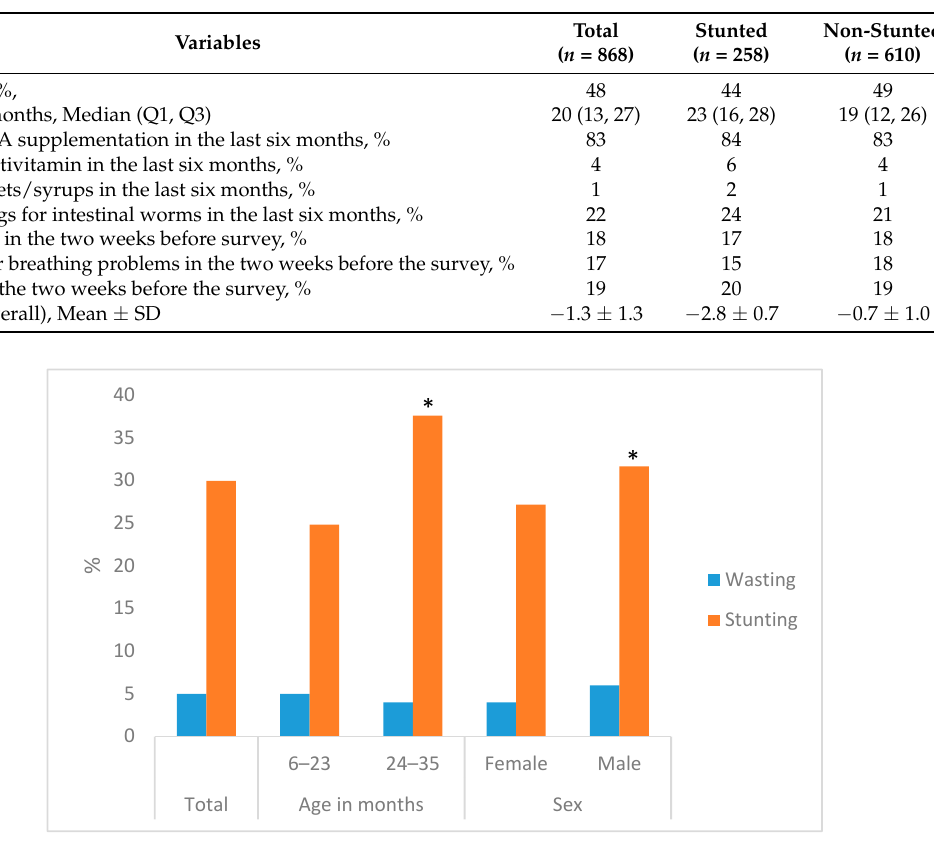
Figure 2. Nutritional status of children by age and sex. * p < 0.05, nutritional status different by age and sex.